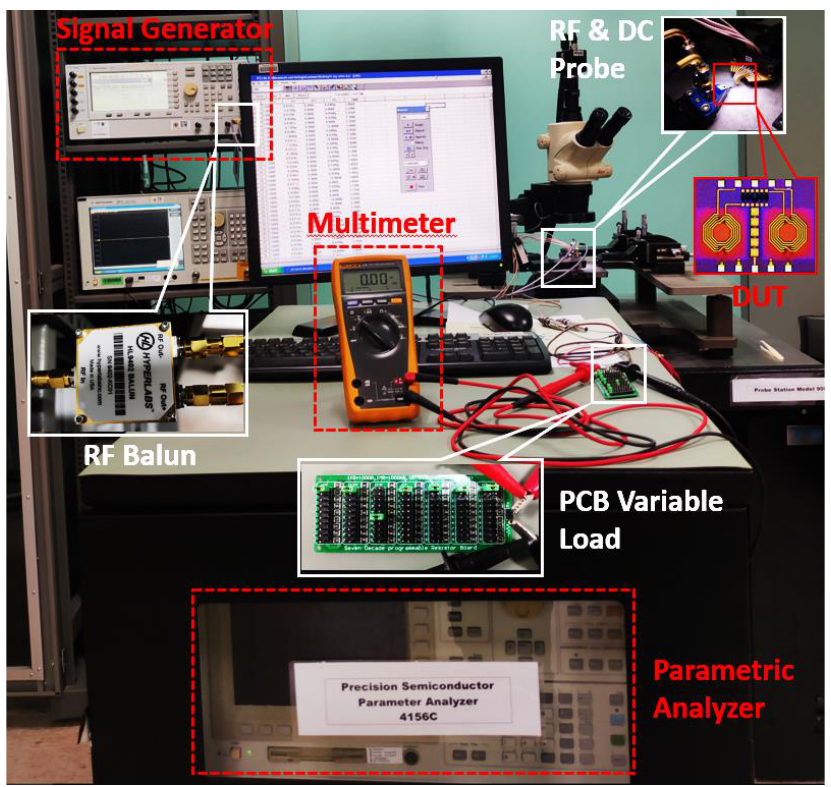
Figure 18. Measurement setup for the validation of CCDD-TVB rectifier.